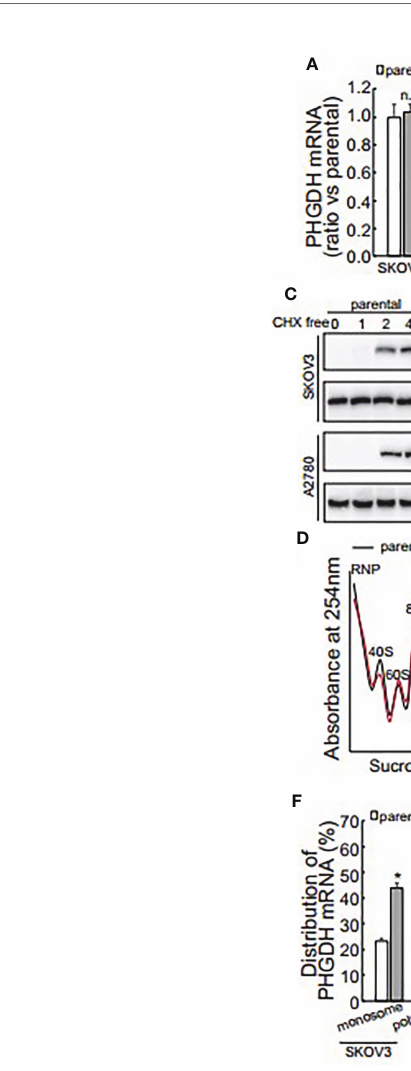
FIGURE 4 | Translational activation is responsible for upregulation of PHGDH in platin-resistant ovarian cancer cells. (A) PHGDH mRNA expression was analyzed using real-time RT-PCR in ovarian cancer cell lines. (B) PHGDH expression was analyzed using Western blot after cells were incubated with the solvent vehicle, MG132, or E64D and pepstatin A for 24 h. (C) Ovarian cancer cells were treated with cycloheximide (CHX) for 16 h, then CHX were completely washed out. PHGDH expression was analyzed using Western blot analysis after Cells were cultured under complete media for the additional indicated time. (D, E) SKOV3 (D) or A2780 (E) Cells were exposed to CHX for 10 h, cell homogenate was subjected for sucrose gradient fractionation. Absorbance at 254 nm was measured in each fraction. (F, G) total RNA was isolated from monosome and polysome fractions, PHGDH mRNA (F) and GAPDH mRNA (G) occupation on monosome and polysome fractions was analyzed using real-time RT-PCR. * P < 0.05, n.s., not signi fi